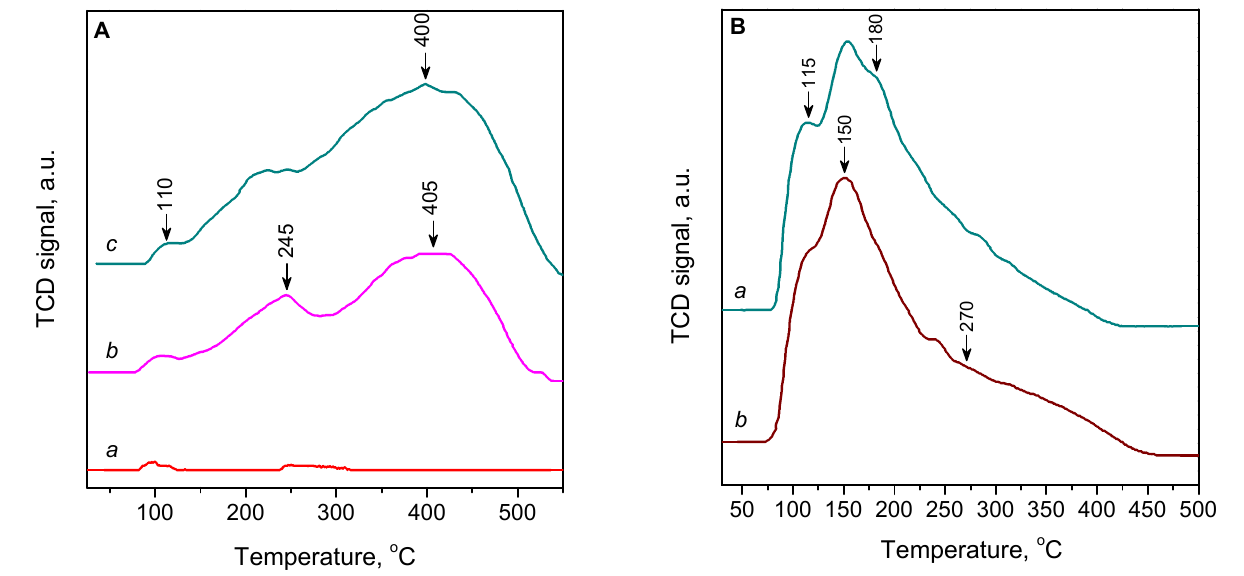
Figure 9. ( A ) CO-TPD curves of 2.3CuZ23(AE) activated in O 2 /He (a) and samples reduced with CO/He: 2.3CuZ23(AE) (b) and 3.1CuZ23(AE) (c). ( B ) CO-TPD curves of sample 9.7CuZ23(SE) activated in He (a) and reduced with CO/He (b).